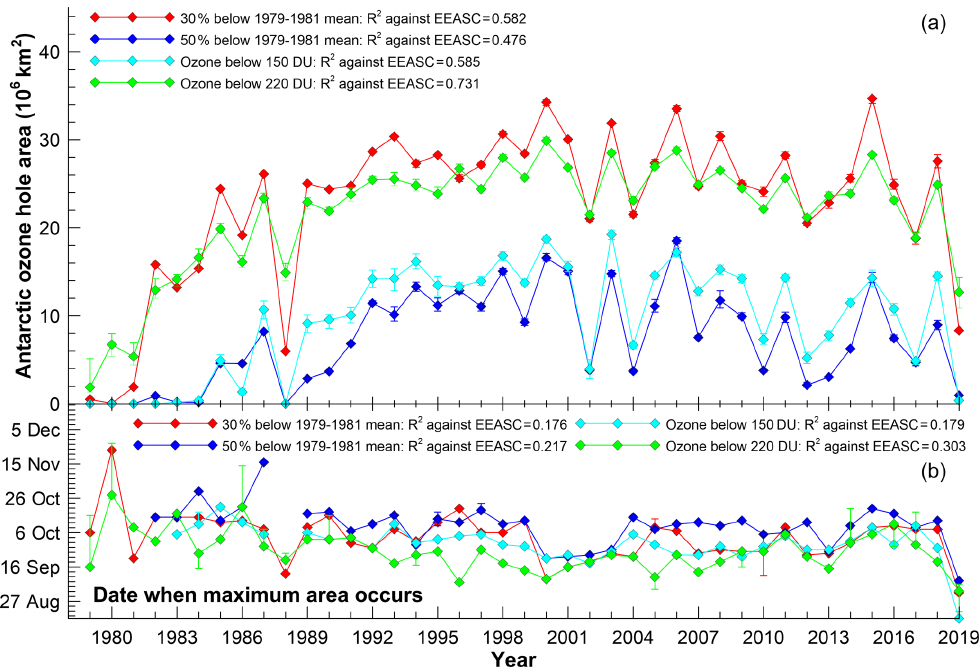
Figure 3. The annual maximum ozone hole area for the four different threshold criteria (a) , and the dates on which those maxima were achieved (b) . Error bars show 1 σ uncertainties, which are often asymmetrical. The R 2 values show the correlation coefficient between each of the time series and EEASC for the years when metrics are available.